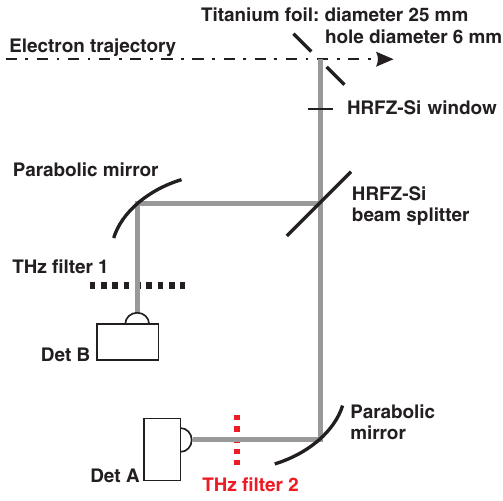
FIG. 48. Schematic setup of the electron bunch length monitor based on coherent diffraction radiation. A window of high- resistivity float-zone (HRFZ) silicon is used to transmit the THz